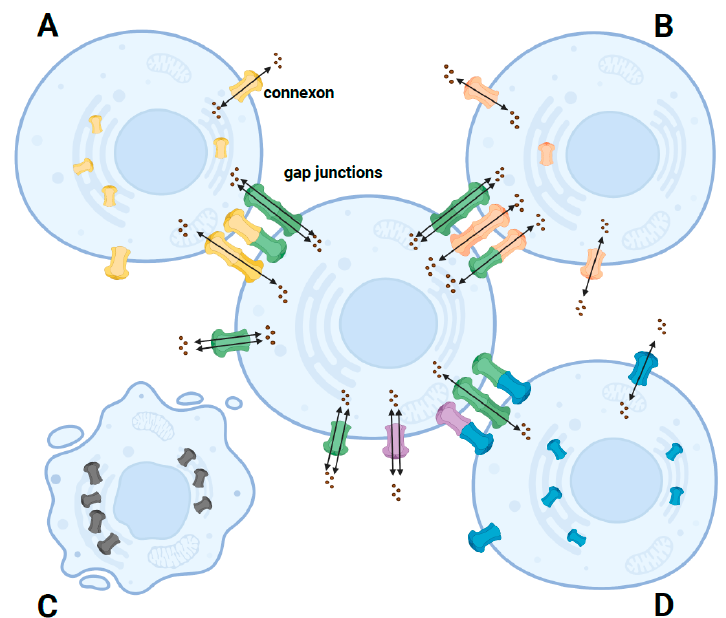
Figure 3. Schematic diagram of the pathogenic mechanism of different phenotypes caused by GJB2 missense mutants. ( A ) In autosomal recessive nonsyndromic HL, most missense mutants are retained in the cell. A small fraction can traffic to the cell membrane, forming nonfunctional or functionally impaired hemichannels or functional homozygous GJ channels but not functional heterozygous channels. ( B ) In autosomal dominant nonsyndromic HL, most missense mutants are correctly trafficked to the cell membrane but form impaired GJ channels. ( C ) In autosomal dominant syndromic HL, some missense mutants can induce cell death due to increased calcium channel activity, resulting in increased hemichannel currents. ( D ) In autosomal dominant syndromic HL, most missense mutants have dominant-negative or trans-dominant effects on wildtype or other proteins, so the connexons coexpressed with the mutant are suppressed and form nonfunctional GJ channels. Green connexons represent the wildtype Cx26; yellow, orange, and blue connexons represent mutated Cx26; purple connexons represent other connexons.